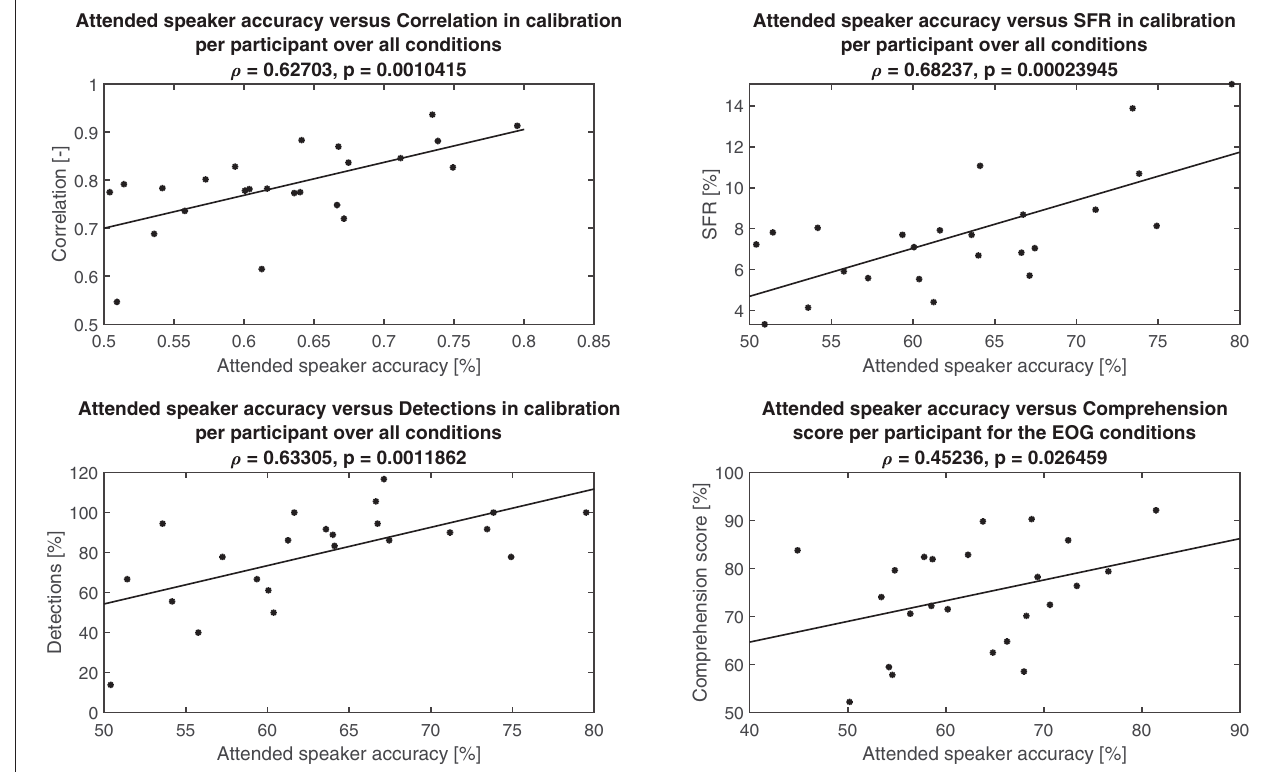
FIGURE 10 | Attended speaker accuracy vs. various metrics per participant together with the least-squares line fit in solid, Pearson’s correlation ( ρ ), and the corresponding p -value. Top left: Correlation metric from calibration procedure. Top right: SFR metric from the calibration procedure. Bottom left: Detection metric from calibration procedure. Note that one outlier showing unreasonable 300% detections was removed. Bottom right: Comprehension score in the EOG